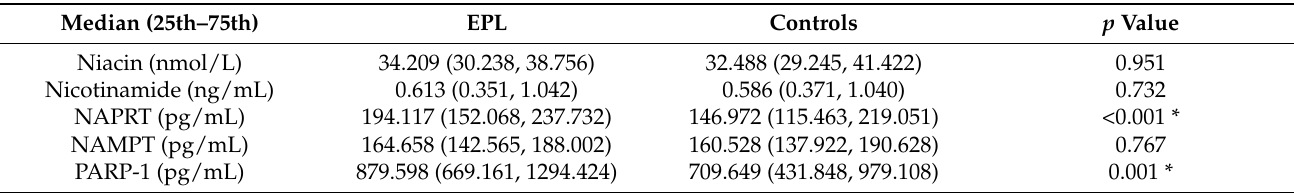
Table 1. Comparison of NAD-related variables between two